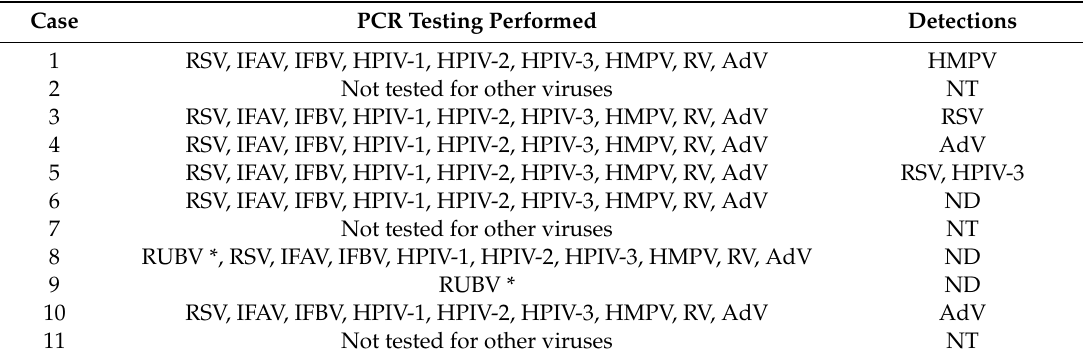
Table 4. Results from other PCR testing performed on respiratory specimens in referring laboratories using the same specimen or a specimen collected around the time of the positive measles